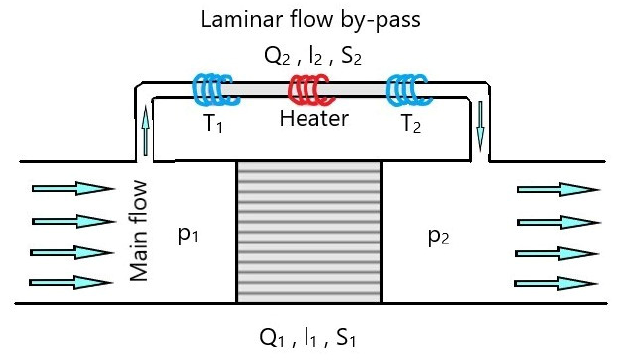
Figure 1. Diagram of a capillary thermal flow meter.